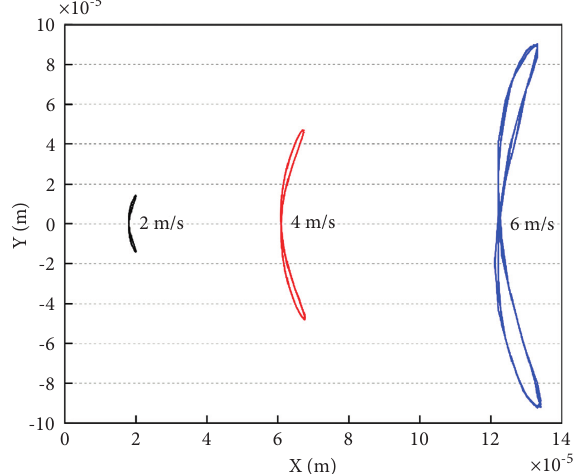
Figure 16: Vibration displacement curves at different velocities.